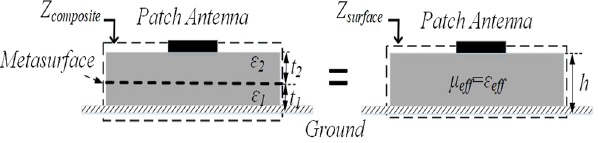
Fig. 1. Cross sectional diagram of the meteferrite patch antenna and its equivalent magnetic material with effective m eff = e eff .